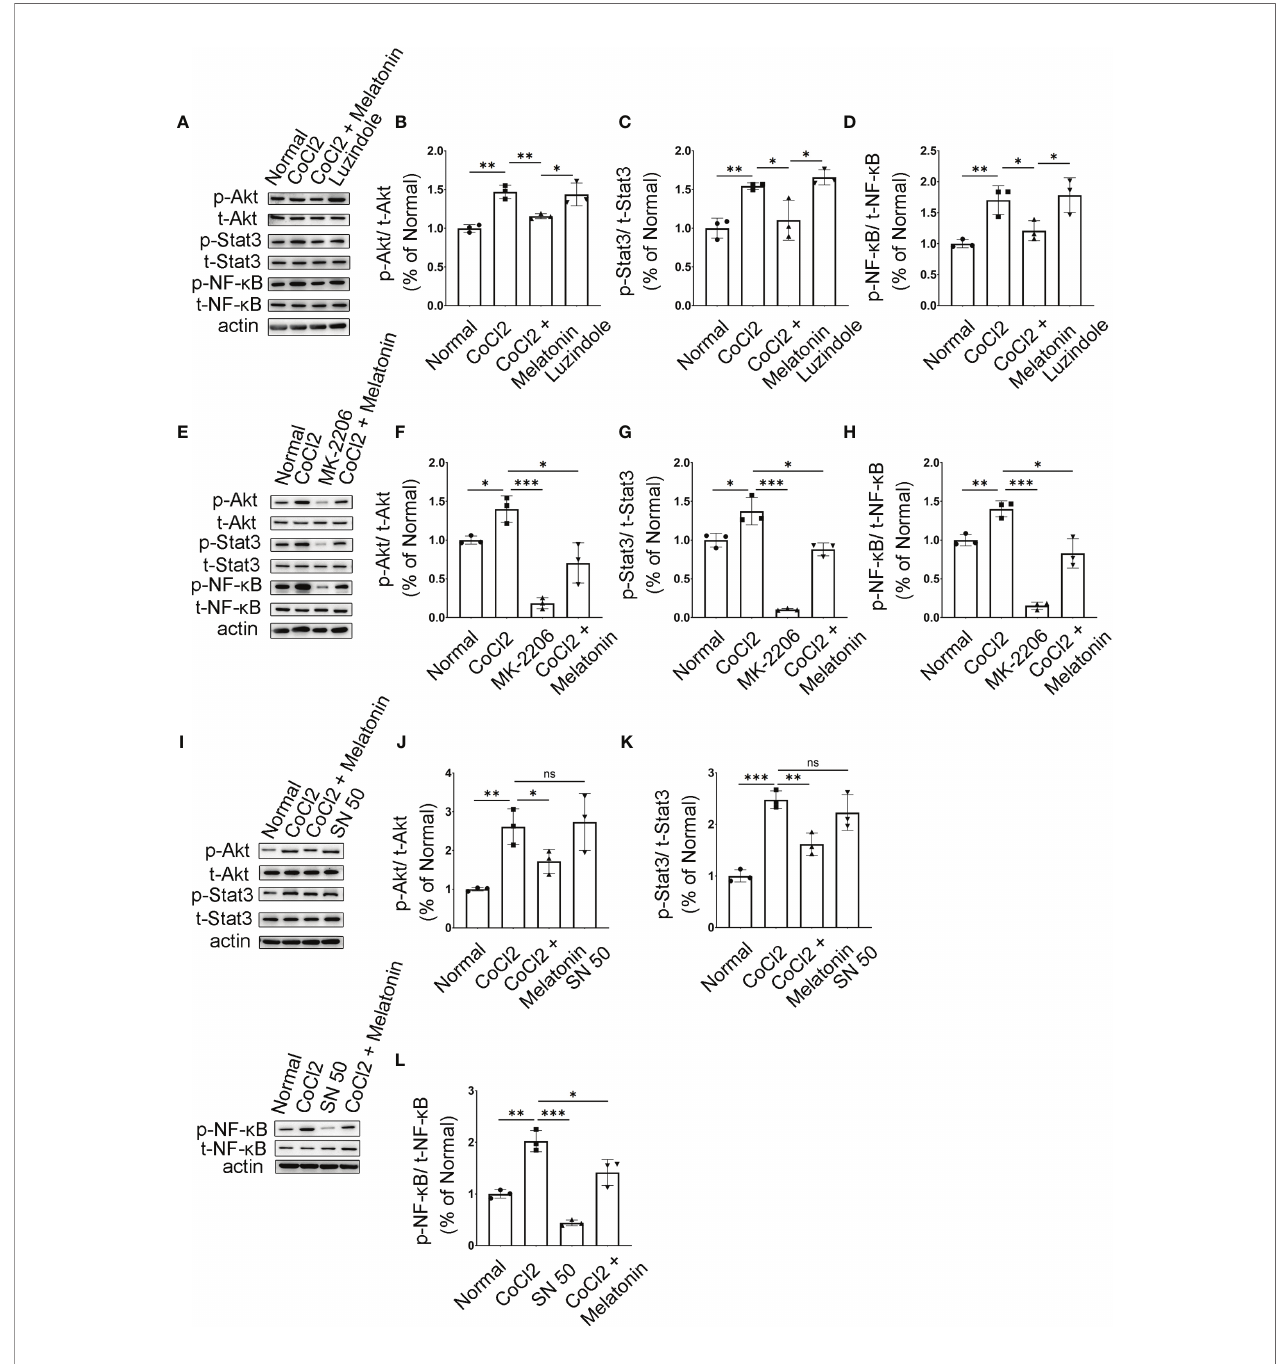
FIGURE 9 | Melatonin inhibits PI3K/Akt/Stat3/NF- k B signaling pathways in CoCl 2 -treated microglia. (A – D) Protein expressions of p-Akt, p-Stat3, and p-NF- k B in the control group, CoCl 2 group, CoCl 2 + melatonin group, and luzindole. (E – H) Protein expressions of p-Akt, p-Stat3, and p-NF- k B in the control group, CoCl 2 group, CoCl 2 + melatonin group, and MK2206. (I – L) Protein expressions of p-Akt, p-Stat3, and p-NF- k B in the control group, CoCl 2 group, CoCl 2 + melatonin group, and SN50. Data are expressed as mean ± SEM (n = 3 per group); *p < 0.05, **p < 0.01, ***p < 0.001 by one-way ANOVA. ns, non-signi fi cant